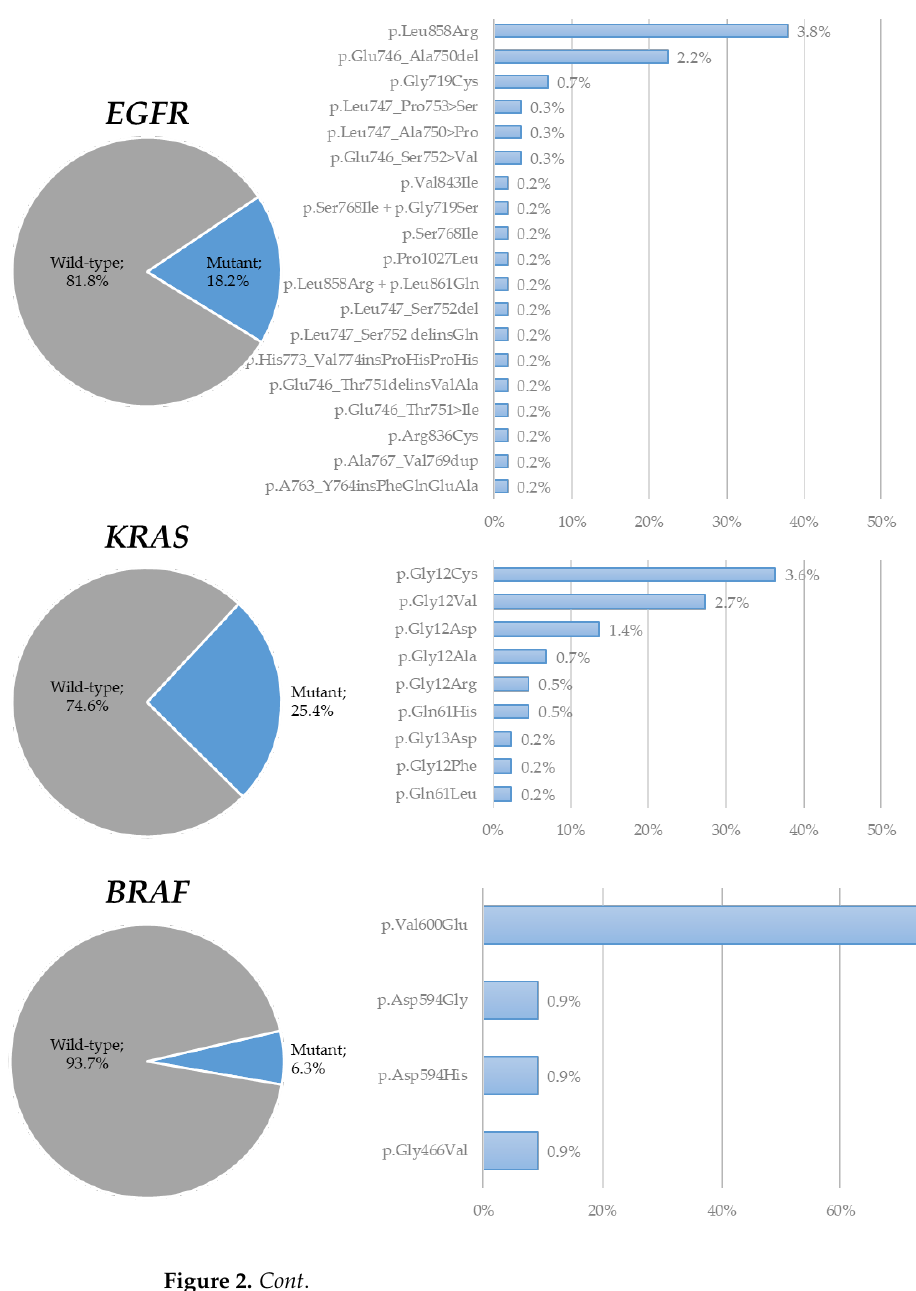
Table 2. Throughput of analyses during the study period. OPA: Oncomine Precision Assay. DNA 252 RNA 254 OPA analyses Failed DNA 10/252 (4%) Overall = 506 Failed RNA 5/254 (2%) Of the 259 patients with NS-NSCLC with valid or available NGS analysis ( n = 242), driver molecular alterations were detected as follows (Figure 2): EGFR, 44 (18.2%); KRAS, 61 (25.4%), BRAF, 15 (6.3%); ALK 10 (4.3%); ERBB2, 4 (1.7%); MET, 4 (1.7%); ROS1 11 (2.3%); RET, 9 (1.9%), and NTRK, 2 (0.8%), with additional alterations detected with an incidence below 1% (e.g., IDH1, CDKN2A, FGFR3, KIT, MTOR, FGFR4. NTRK3, NRAS, PIK3CA,